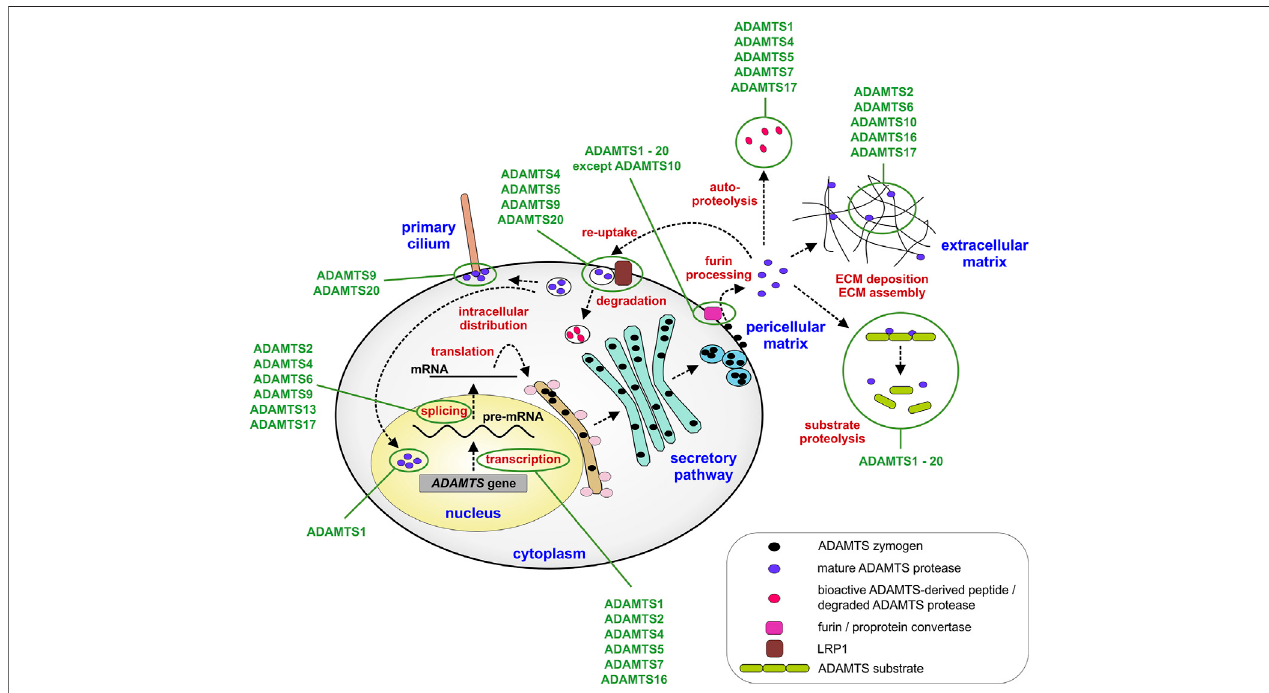
FIGURE 2 | Steps that regulate ADAMTS protease expression and activity. ADAMTS proteases can be regulated transcriptionally, during mRNA splicing or translationintoprotein.Majorposttranslationalregulatorystepsincludefurin-mediatedactivationofADAMTSproteasesandthelocalizationofADAMTSproteaseactivity in the pericellular or extracellular matrix. In addition, re-uptake of active ADAMTS proteases mediated by LRP1 results in the localization of ADAMTS protease activity to intracellular compartments, such as the primary cilium or the nucleus or in the clearance of protease activity from the extracellular matrix. Cellular and extracellular compartments are labeled in blue and points of regulation in red. Some ADAMTS proteases discussed in the review are depicted. Exceptions, such as activation of ADAMTS proteases in the secretory pathway or the ECM or absence of furin processing are described in the text only.